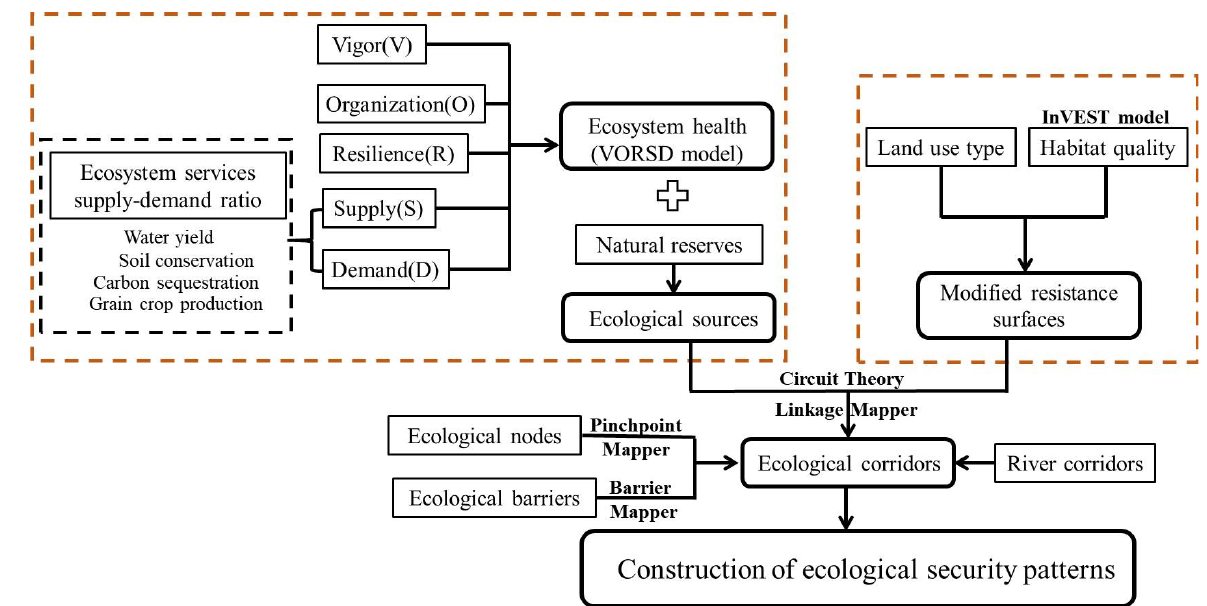
Figure 2. Research framework.